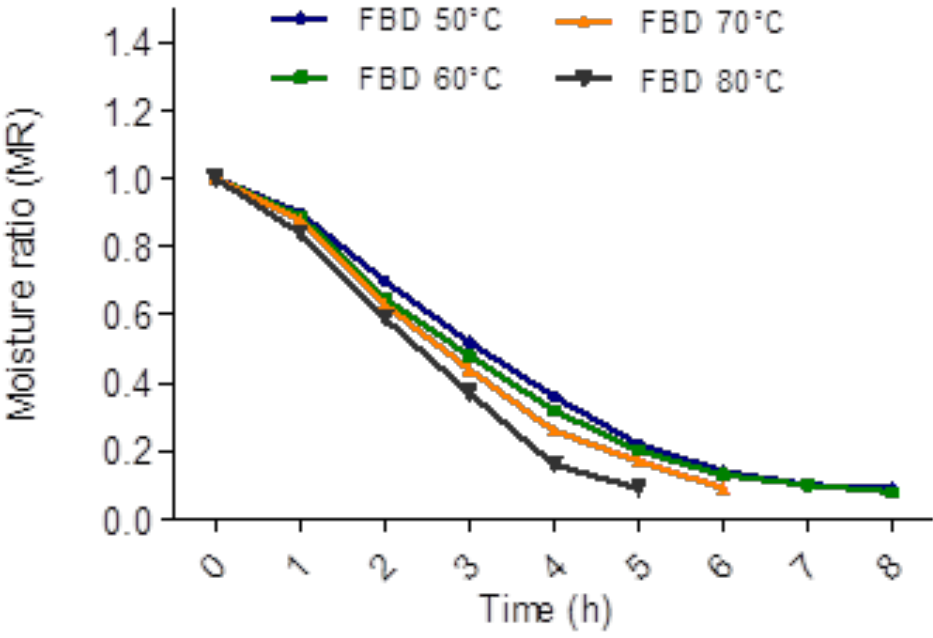
Figure 3. Fluidized bed drying kinetics at different temperatures.